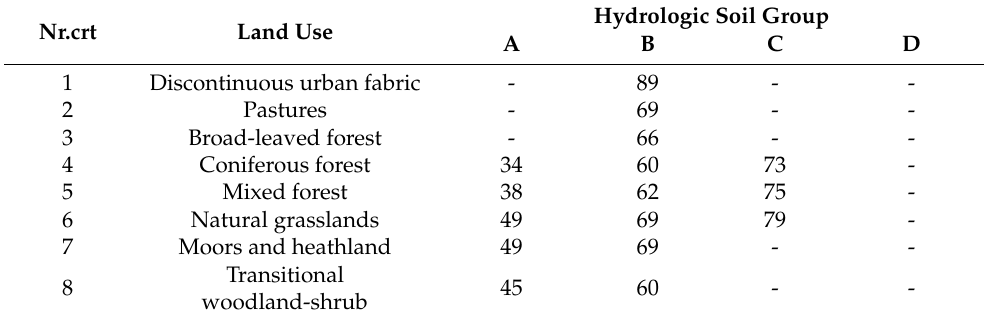
Table 2. The CN values of land use types and hydrologic soil groups used in the present study.